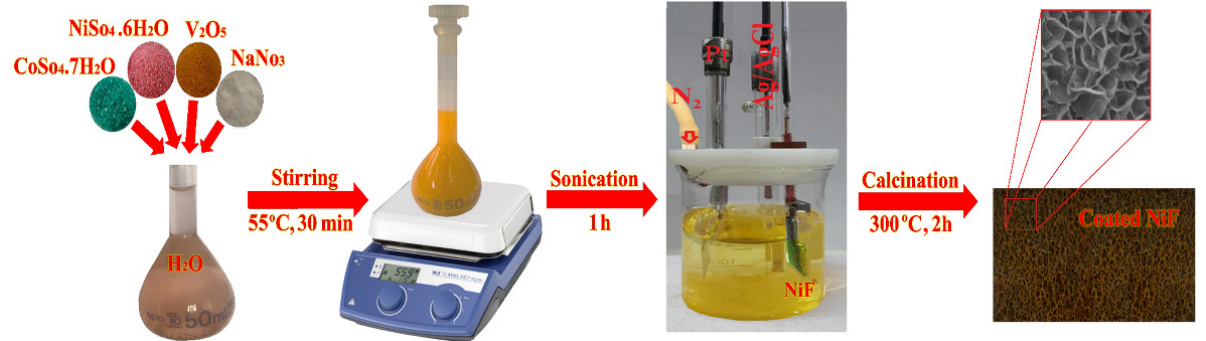
Figure 1. Schematic illustration of electrochemical deposition of Co x NiV y O z ternary nanocomposite on Ni foam substrate: prepared aqueous electrolyte solution, sonicated precursor, and deposition precursors on a Ni foam substrate in a three-electrode deposition